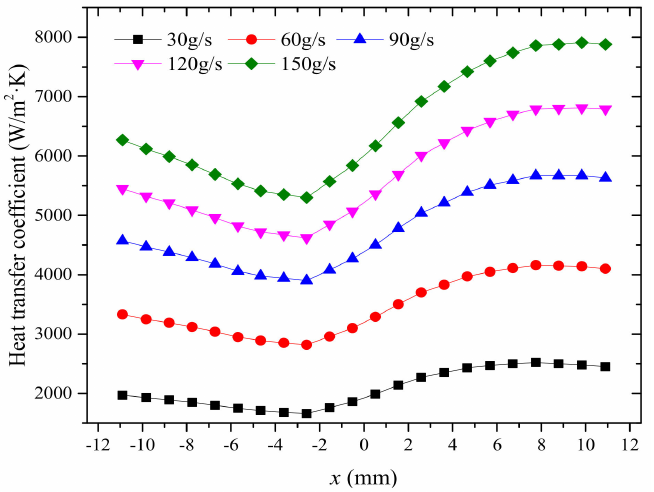
Figure 13. The distribution of the heat transfer coefficient of the target surface along the x